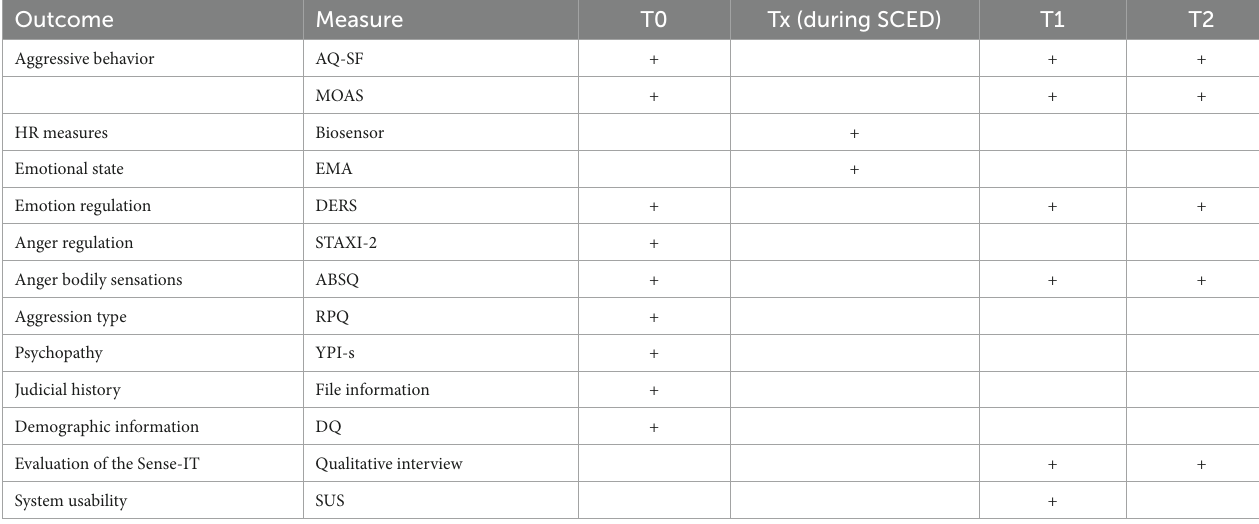
TABLE 1 Overview of outcomes, measures, and moment of assessment.